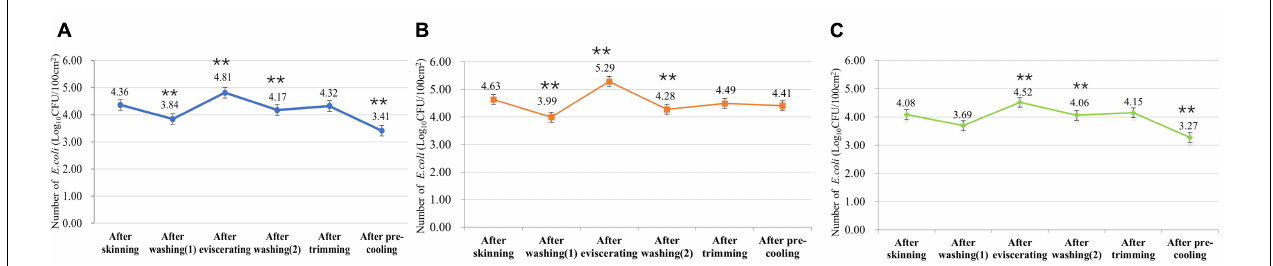
FIGURE 1 | Escherichia coli contamination of surfaces of swine carcasses in slaughterhouses of different sizes. (A) Number of E. coli in all swine slaughterhouses. (B) Number of E. coli in small swine slaughterhouses. (C) Number of E. coli in big swine slaughterhouses. **means the statistical difference between this process and the previous process is extremely significant ( P <